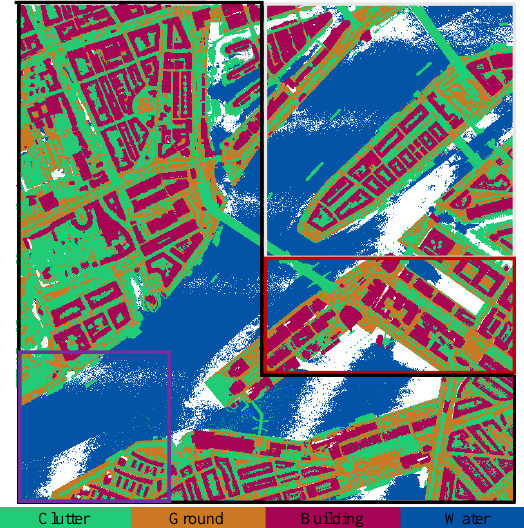
Water Figure 3. An overview of the study area. The training area is in the black box. The validation area is in the red box and the testing area is in the grey box. The area to initialize the model is in the purple box.